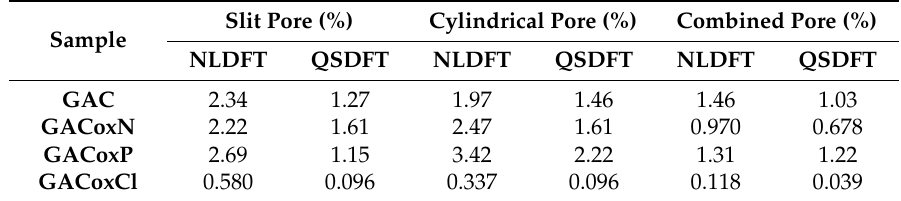
Table 1. Fitting error (%) for different pore geometry (slit, cylindrical, and combined) assuming either homogeneous surfaces (NLDFT) or rough/heterogeneous surfaces (QSDFT). Slit Pore (%) Cylindrical Pore (%) Combined Pore (%) Sample